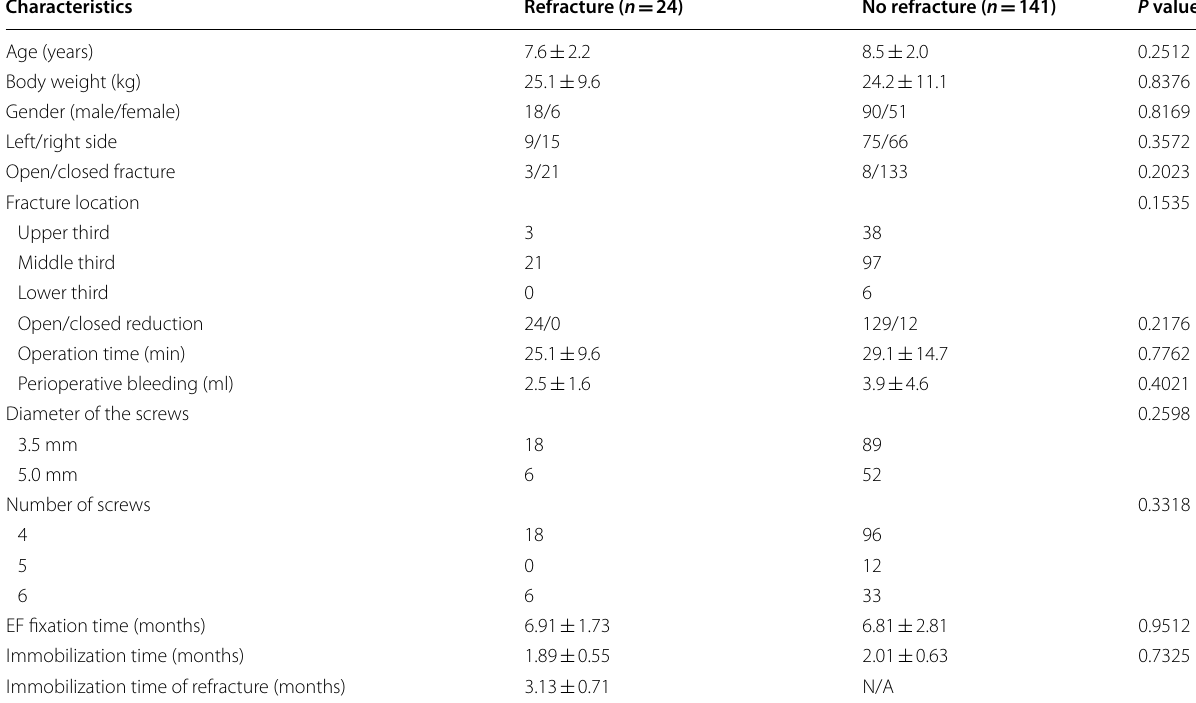
Table 1 Comparison of demographic and clinical characteristics between patients with and without